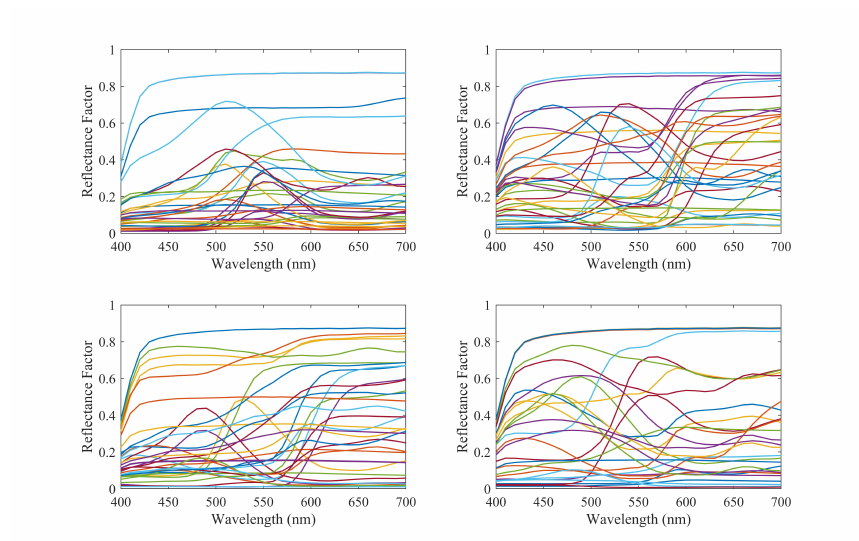
Figure 3. Spectral curves of the samples in the testing